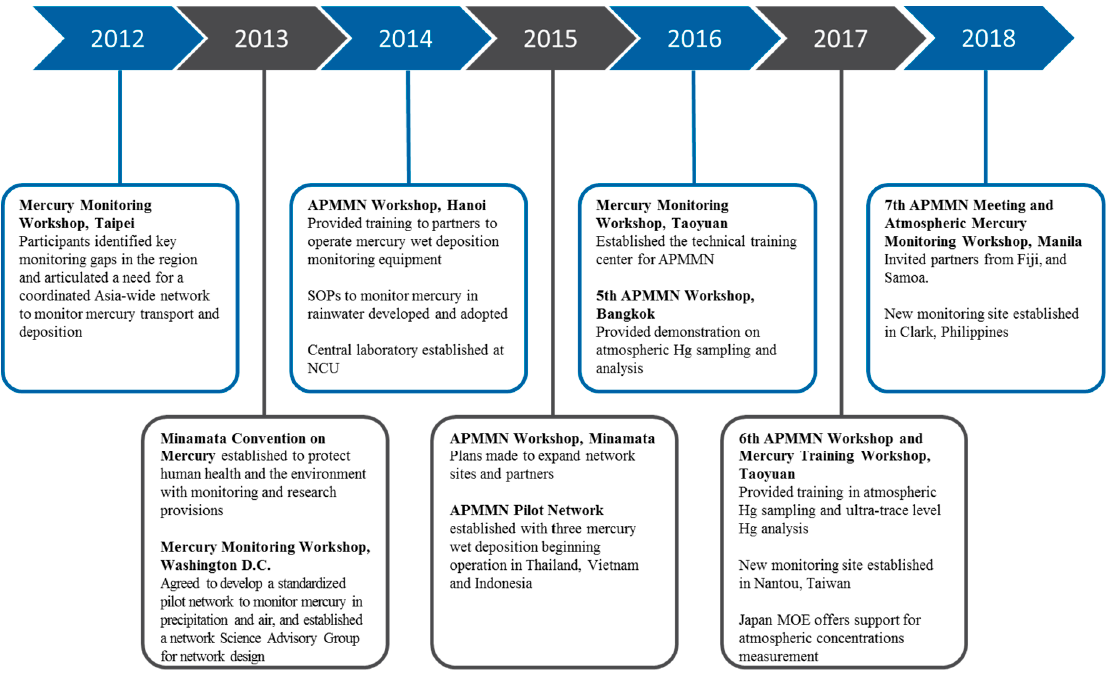
Figure 1. Timeline for the development of the Asia Pacific Mercury Monitoring Network, 2012 through 2018.